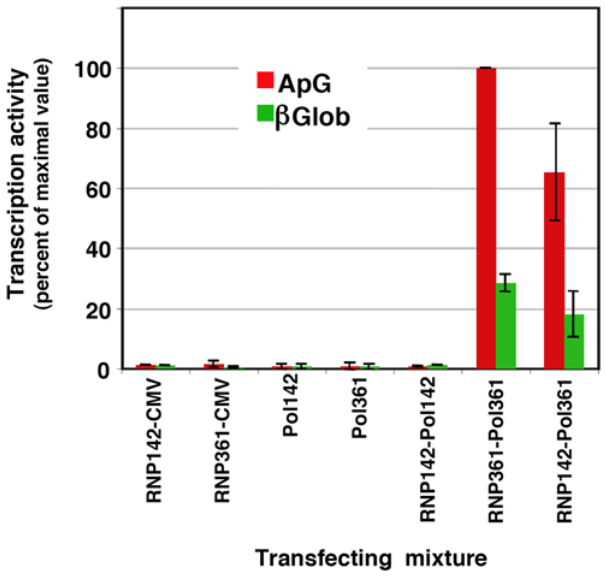
Figure 5. Phenotype of trans -complemented RNPs. The purified RNP preparations presented in Fig. 3 were tested for in vitro transcription primed with either ApG (red) or b -globin mRNA (green). The data are presented as percent of maximal value and represent the averages and range of two independent complementation experi- ments. The transfecting RNPs are denoted as RNP142 or RNP361. The genotypes of the transfected polymerases are indicated as Pol142 or Pol361. CMV indicates the transfection of empty pCMV plasmid. The transcription activities parallel the values of NP accumulation presented in Fig. 3 and show that the rescued RNPs have a cap-snatching